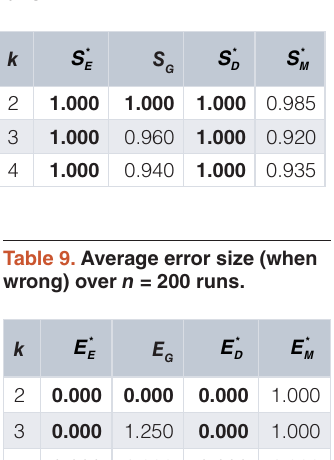
Table 8. Success rate over n = 200 runs.